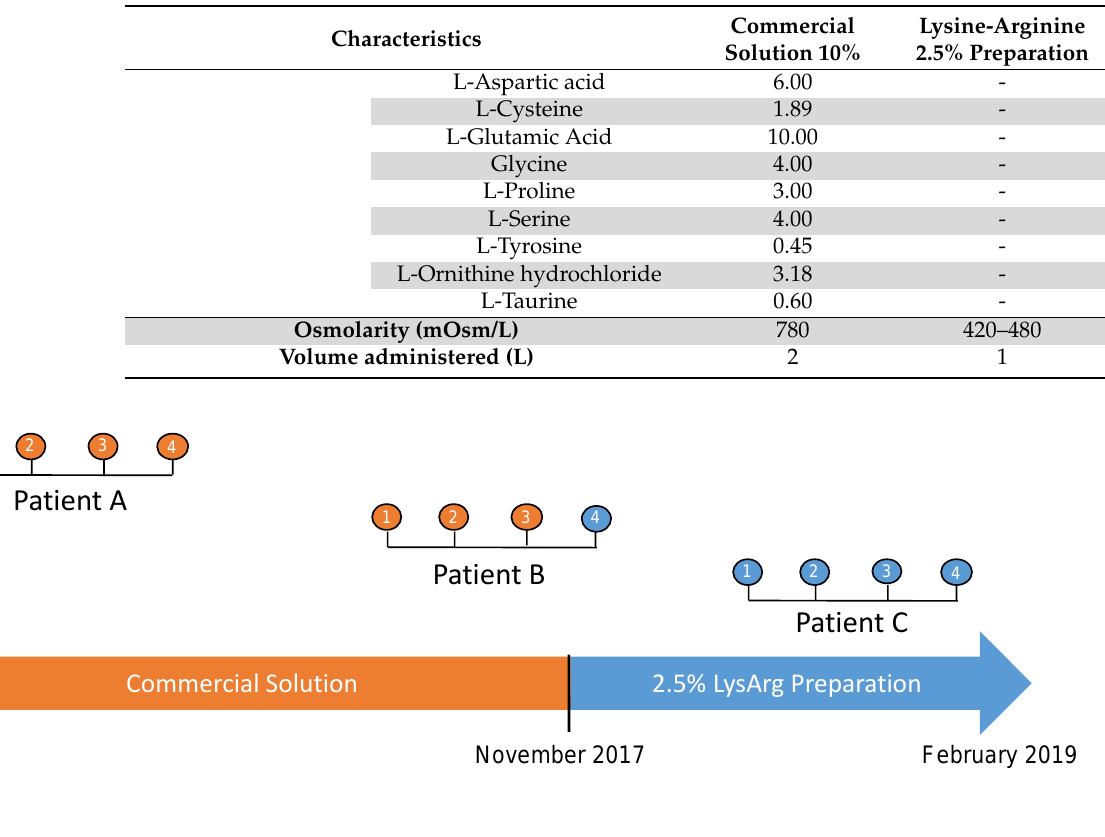
Figure 1. Flow-chart representing timeline use of different amino acid solutions (CS: commercial solution; LysArg: L-lysine L-arginine). From February 2016 to February 2019, all patients were treated with CS solution. After November 2017, all patients were treated with LysArg preparation. PPRT consisted of 4 cycles (1 to 4) of [ 117 Lu]oxodotreotide every 8 Table 1. Composition of the two solutions.